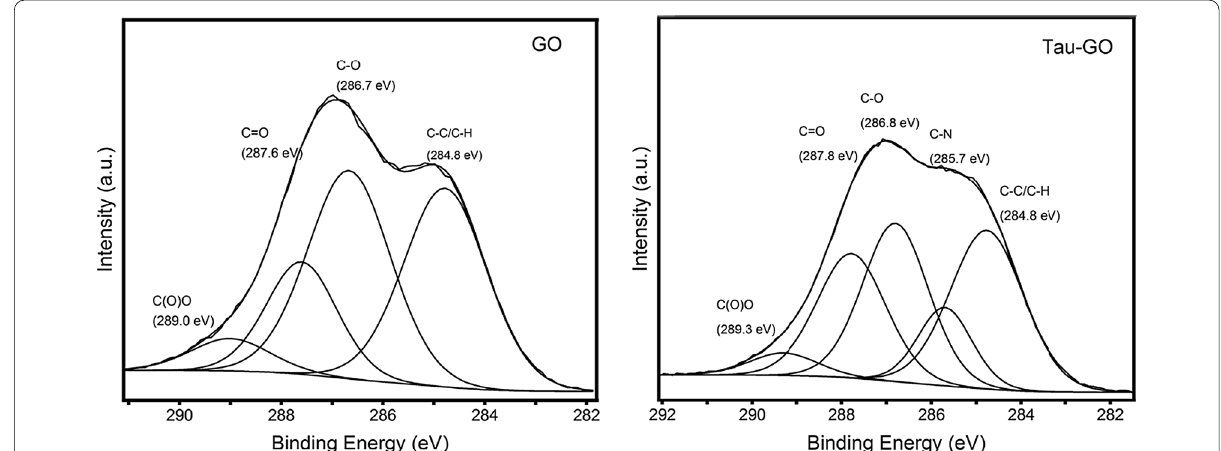
Fig. 9 C1s XPS patterns of GO and Tau-GO